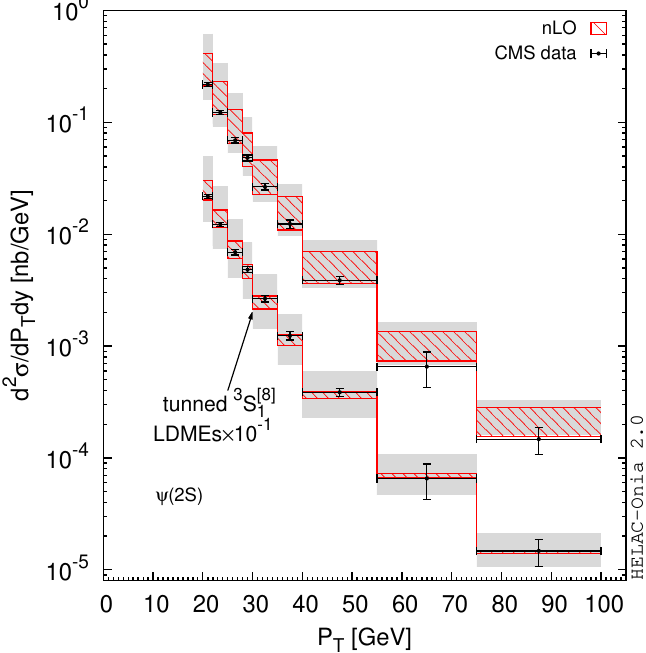
Figure 11 . Comparisons of the nLO (2 S ) differential cross sections d 2 (cid:27) CMS measurement